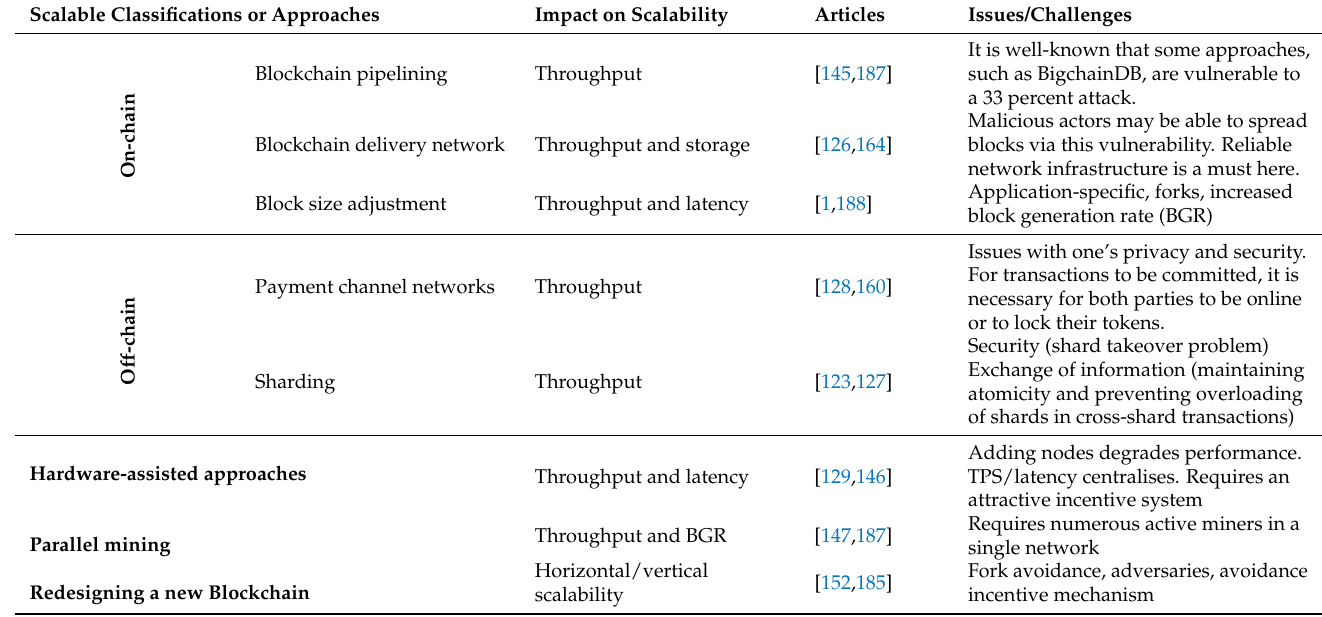
Table 16. Prior approaches to enhance electoral